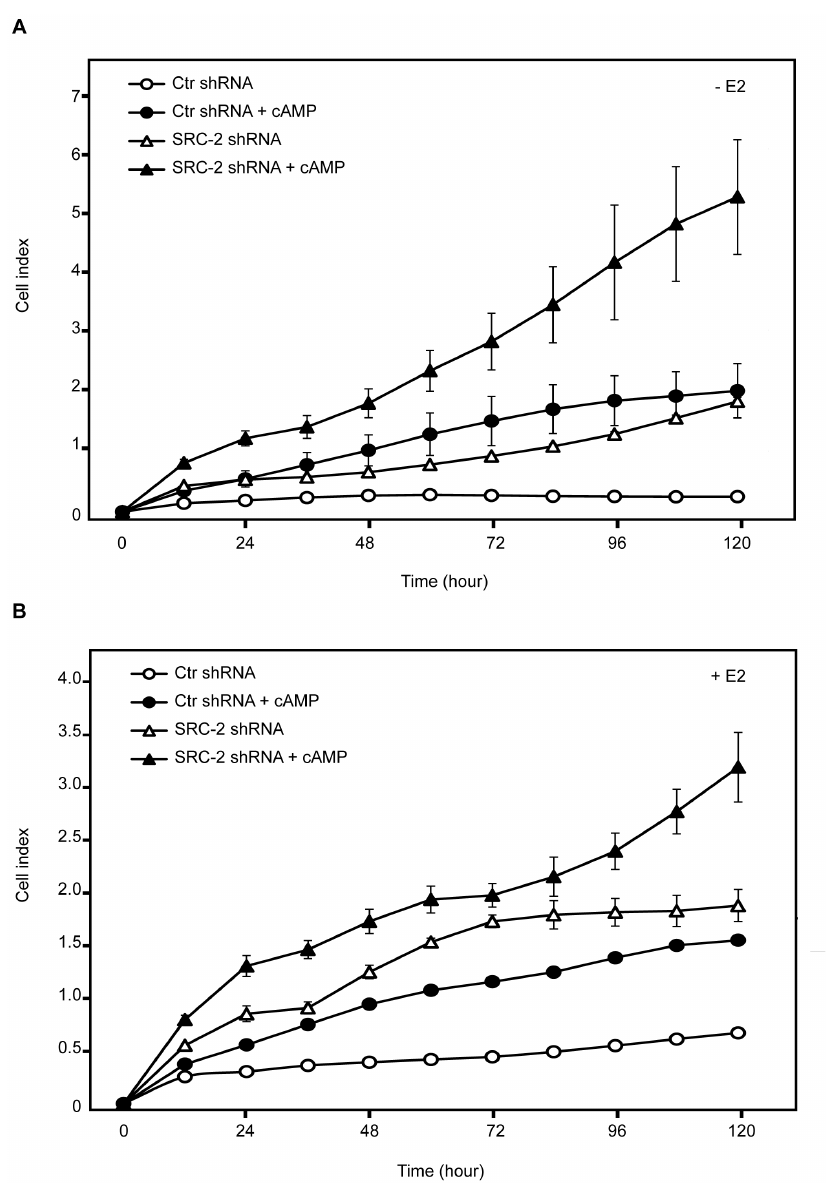
Figure 4. Downregulation of SRC-2 promotes proliferation of MCF-7 cells. MCF-7 cells with KD of SRC-2 (SRC-2 shRNA) and control shRNA MCF-7 cells (Ctr shRNA) grown in phenol red-free DMEM supplemented with charcoaled stripped FBS (5%) for three days, were seeded in E-Plate 16 and treated with either Vehicle or 8-CPT-cAMP (150 m M), IBMX (50 m M) and forskolin (10 m M) (cAMP), in the absence or presence of 17 b -estradiol (E2, 10 nM) (A and B, respectively). Proliferation of the cells was measured by using the xCELLigence system monitoring cellular impedance continuously for 120 hours. The results are representative of at least three independent experiments.